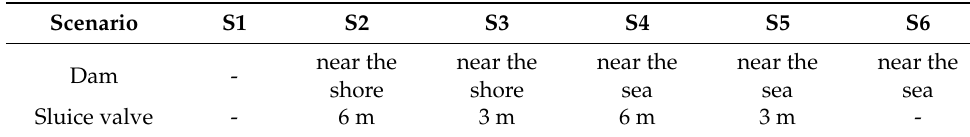
Table 2. Dam and gate valve settings in different scenarios.